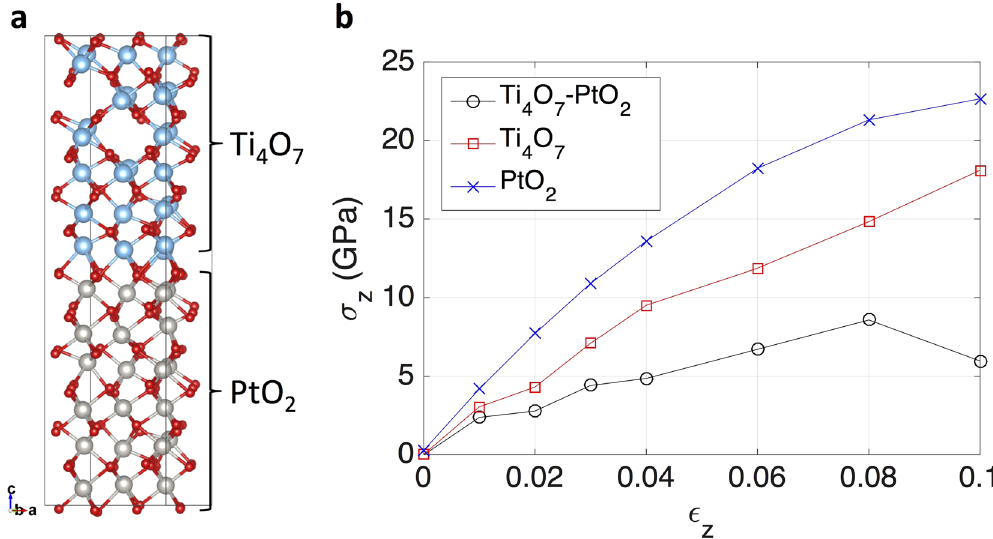
Figure 6. ( a ) Illustration of an interface between Ti 4 O 7 and PtO 2 (interface area: 52.5 Å). The blue, grey, and red spheres indicate Ti, Pt, and O, respectively. ( b ) The stress-strain relationship during elongation in z-axis for three different